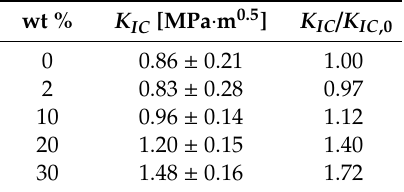
Table 2. Results summary of fracture toughness vs. weight fraction for uniformly distributed and randomly oriented fibers. K IC,0 indicates the toughness of an epoxy-only specimen. wt % K IC [MPa · m 0.5 ]